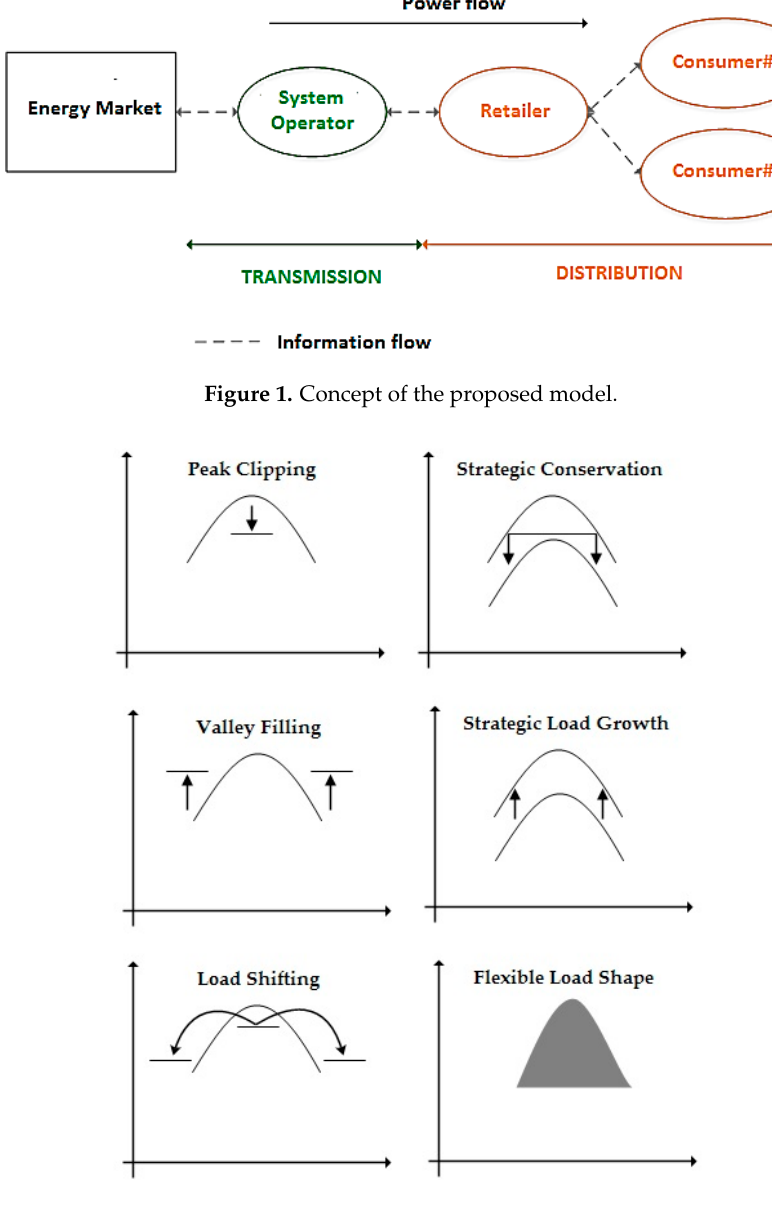
Figure 2. Illustrations of the DSM objectives [69].